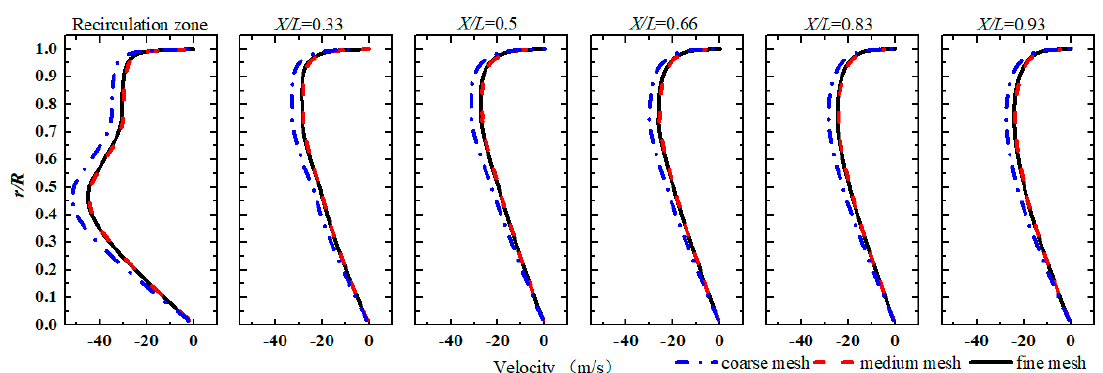
Figure 6. Axial velocity in different axial locations for different mesh number.